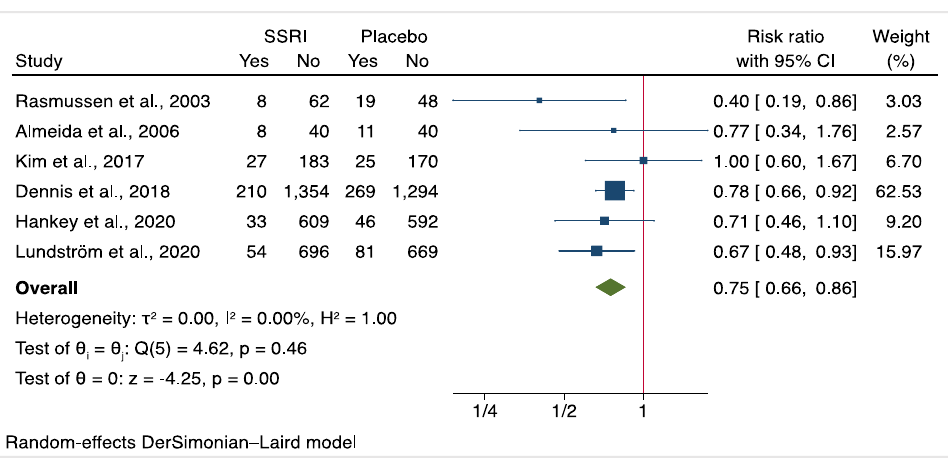
Abbreviations: NIHSS, National Institutes of Health Stroke Scale.